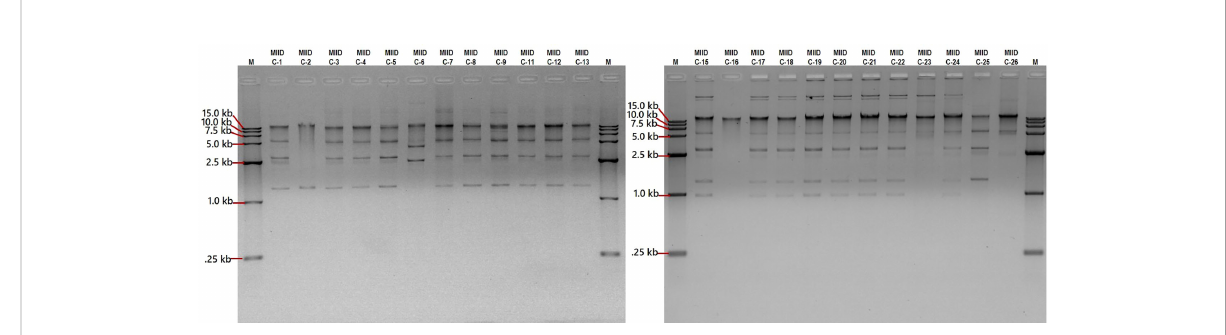
FIGURE 2 Separation of plasmid DNA molecular weight on 0.9% agarose gel stained with ethidium bromide. Lanes M, DNA marker 15.0 kb (cat. no. 239135), lanes MIID-C1 to MIID-26 CRKP clinical isolates carrying different sizes of plasmids.